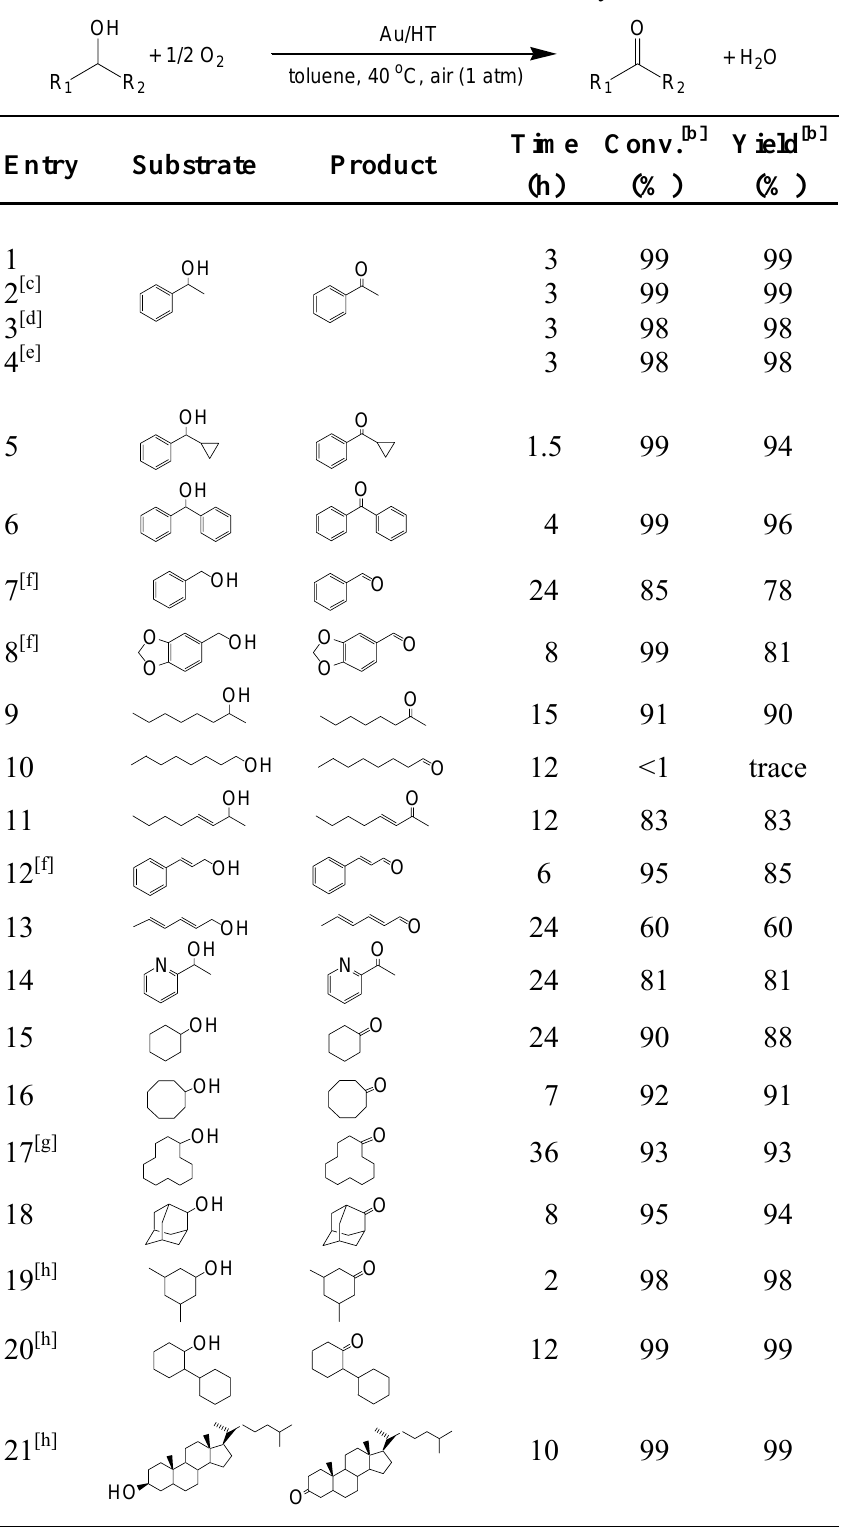
Table 1. Oxidation of Various Alcohols by Au/HT [a] . R 1 R